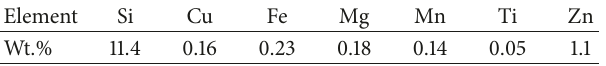
Table 1: Chemical composition of the as received A413.1